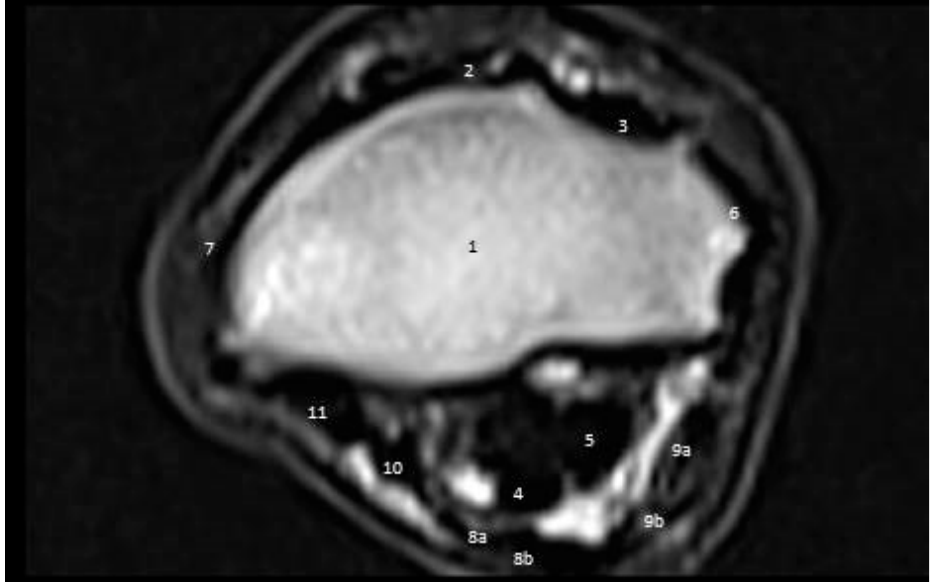
Figure 7. A cross-sectional magnetic resonance imaging scan of the carpal joint in donkeys at the equal of the distal limit of the radius. (1) Radius. (2) Extensor carpi radialis tendon/muscle. (3) Common digital extensor tendon. (4) Superficial digital flexor tendon. (5) Deep digital flexor tendon. (6) Lateral collateral ligament of the carpus. (7) Medial collateral ligament of the carpus. (8) Flexor carpi ulnaris. (8a) Muscle part. (8b) Tendonous part. (9) Ulnaris lateralis tendon. (9a) Muscular part. (9b) Tendon part. (10) Flexor carpi radialis tendon. (11) Carpal fascia.